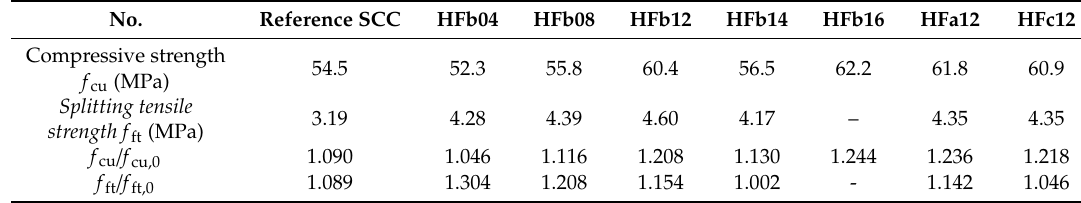
Table 9. The tested strengths and ratios with the designed